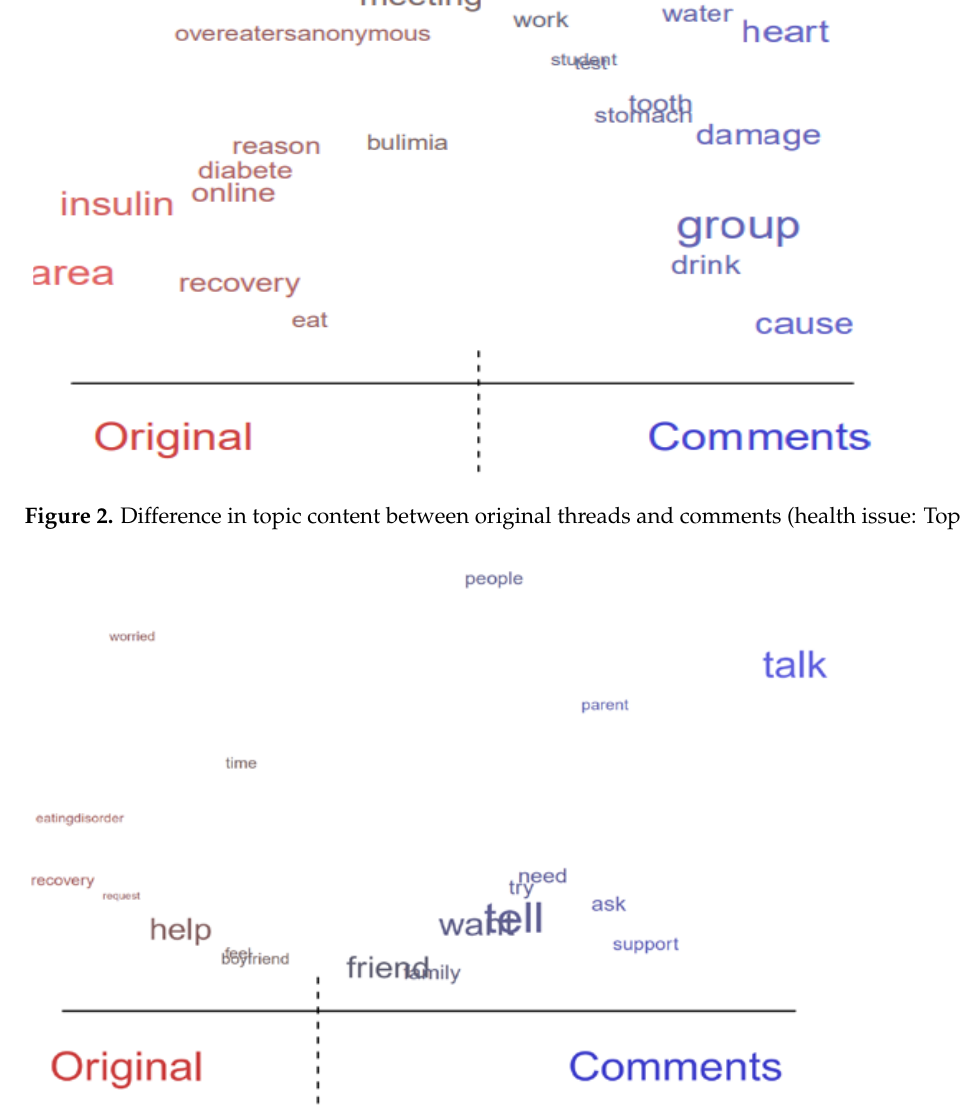
Figure 3. Difference in topic content between original threads and comments (communication: Topic 8).